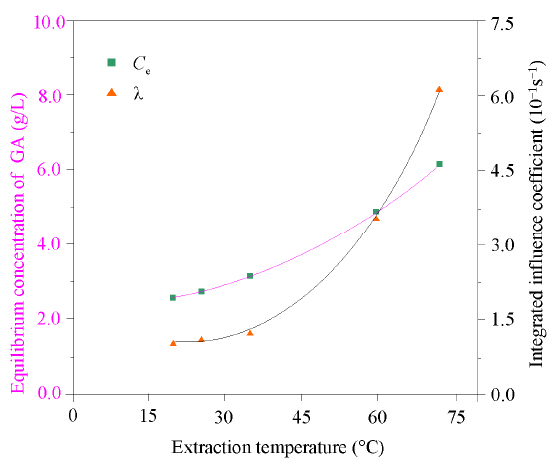
Figure 9. The equilibrium concentration ( C e ) of glycyrrhizic acid, and integrated influence coefficient ( λ ) with different extraction temperatures.